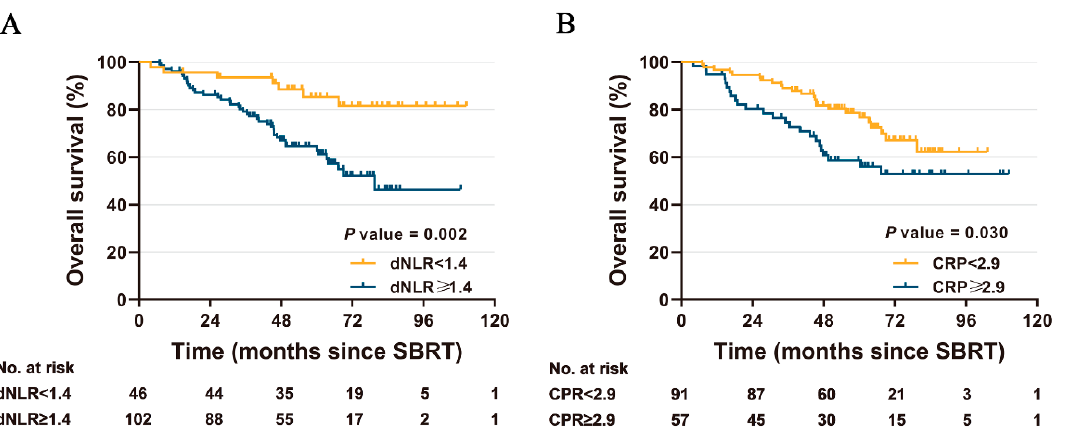
Figure 2. Kaplan-Meier curves for overall survival, stratified by dNLR group ( A ) and CRP group ( B ), respectively.